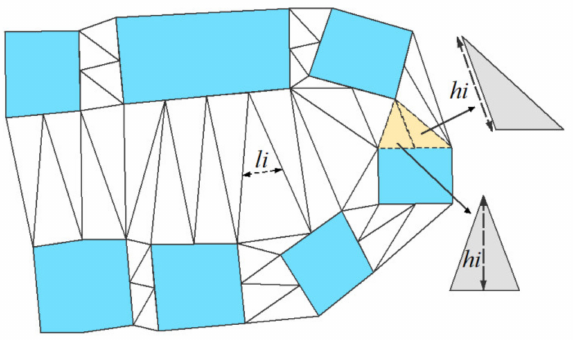
Figure 2. Example of the heights and skeleton lines of adjacent